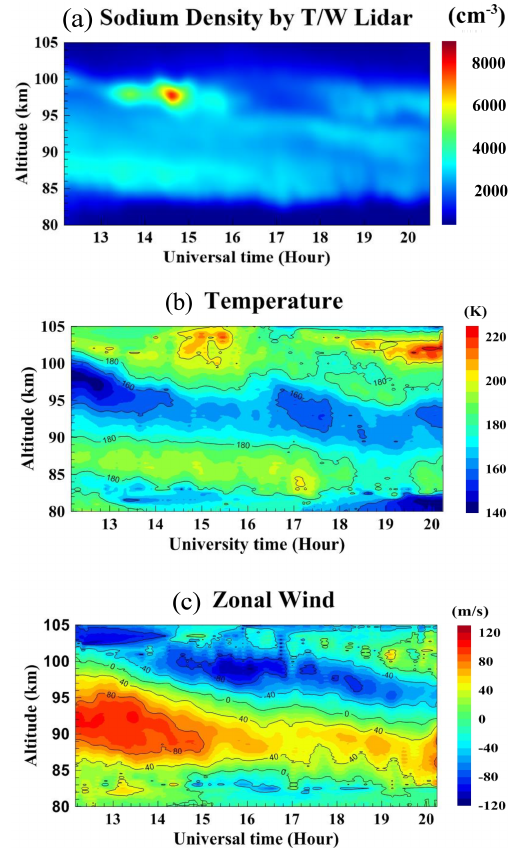
Figure 1. Observations on 3 June 2013, by the T/W lidar of the University of Science & Technology of China (USTC). (a) The sodium density profile of the west beam by the T/W lidar. A moder- ate increase in sodium density appears at about 13:20UT, while the largest intensity of sodium enhancement begins at about 14:20UT. The sodium density peaks at 14:37UT around 97.65km. (b) Tem- perature profile observed by the T/W lidar, showing a cold region where the Na S occurs. (c) The zonal wind detected by the T/W li- dar, exhibiting a suitable wind shear for the creation or formation of E S .